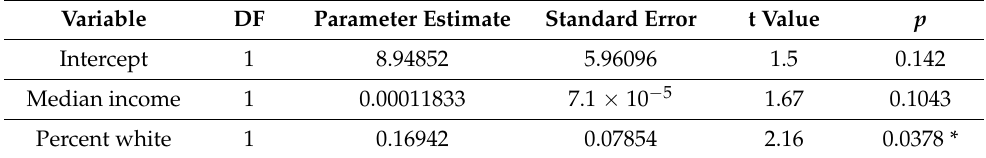
Figure 2. Species Richness for Each Market Class. Average species richness for Supermarket #1, Superstore #1, Supermarket #2, Independent stores, and High-end stores. Standard error bars included. Supermarket #1 and High-end stores had significantly greater species richness than Superstore #1 and independent stores. Table 2. Parameter estimates for multiple regression of income and percent white relationships to produce diversity (N = 39). The “*” indicates results significant at p <